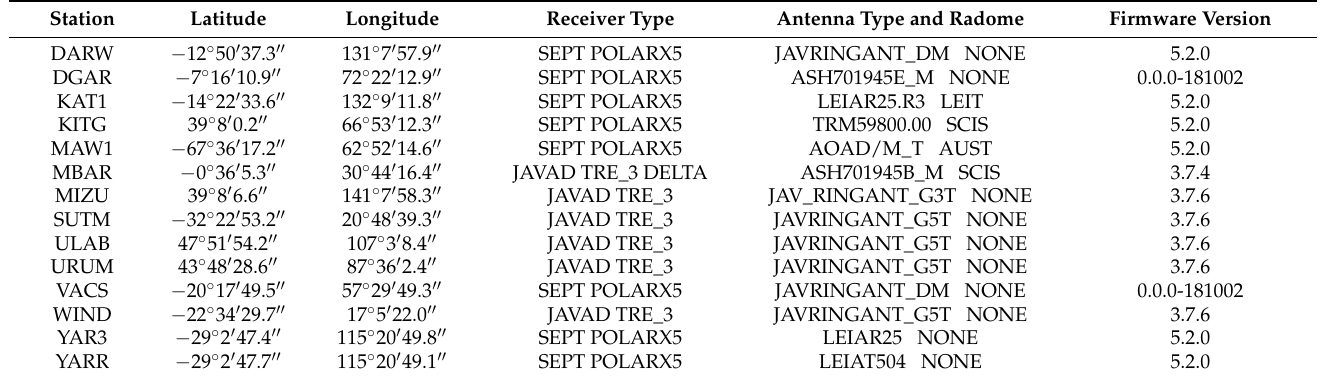
Figure 2. Distribution of 14 MGEX stations. Table 3. Details of each